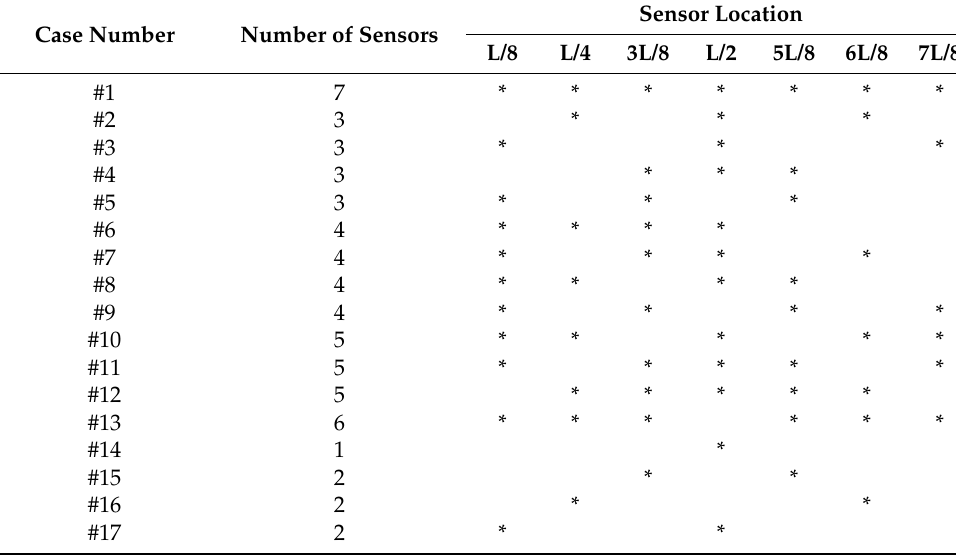
loads. ( a ) Identified front axle load, ( b ) identified rear axle load.